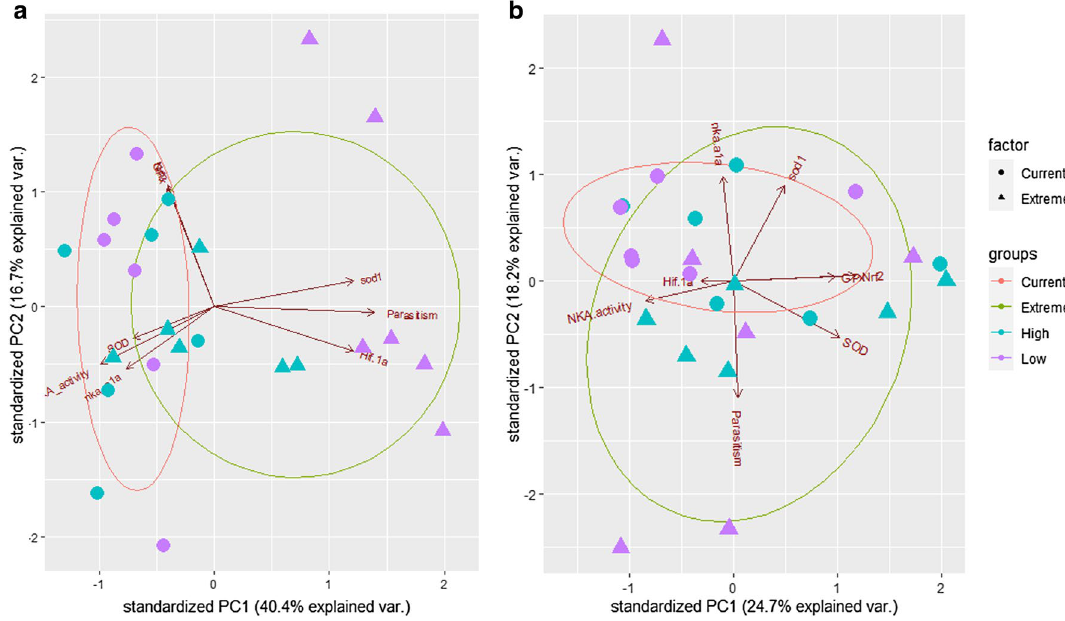
Figure 4. Principal components analysis (PCA) for juvenile tambaqui Colossoma macropomum considering distribution patterns between scenario and parasitism rate (Low (LG) and High (HG)) after seven ( a ) and thirty days ( b ) of exposure.